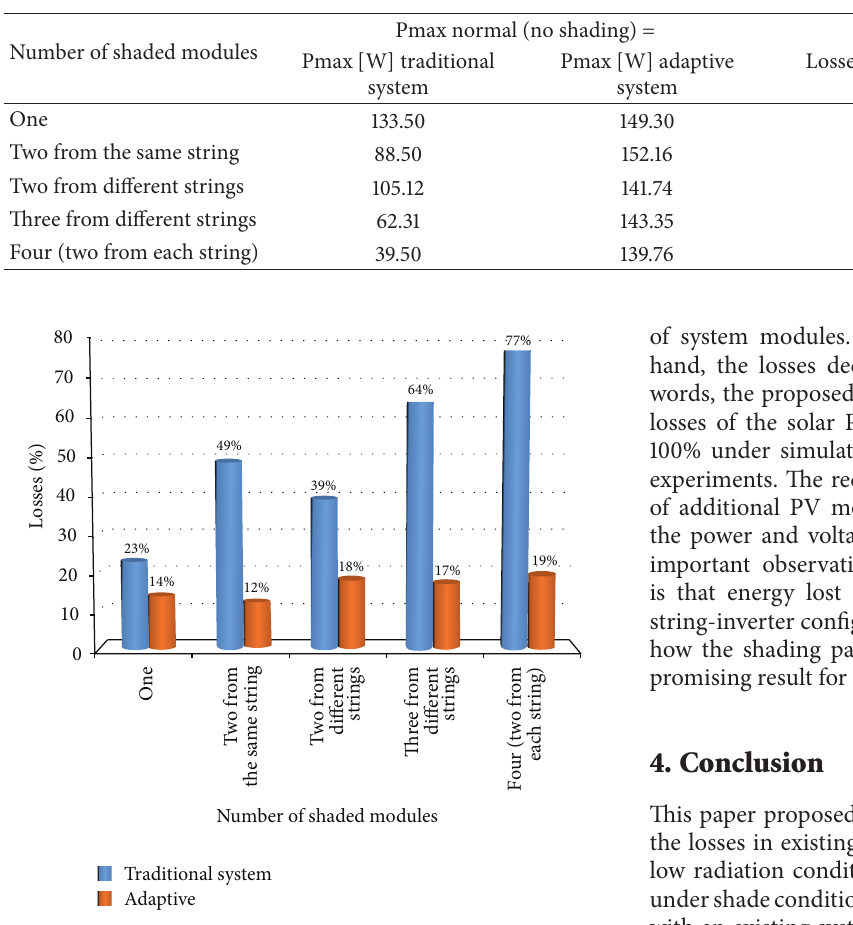
Table 1: Comparison of shading losses between traditional system and the proposed system.